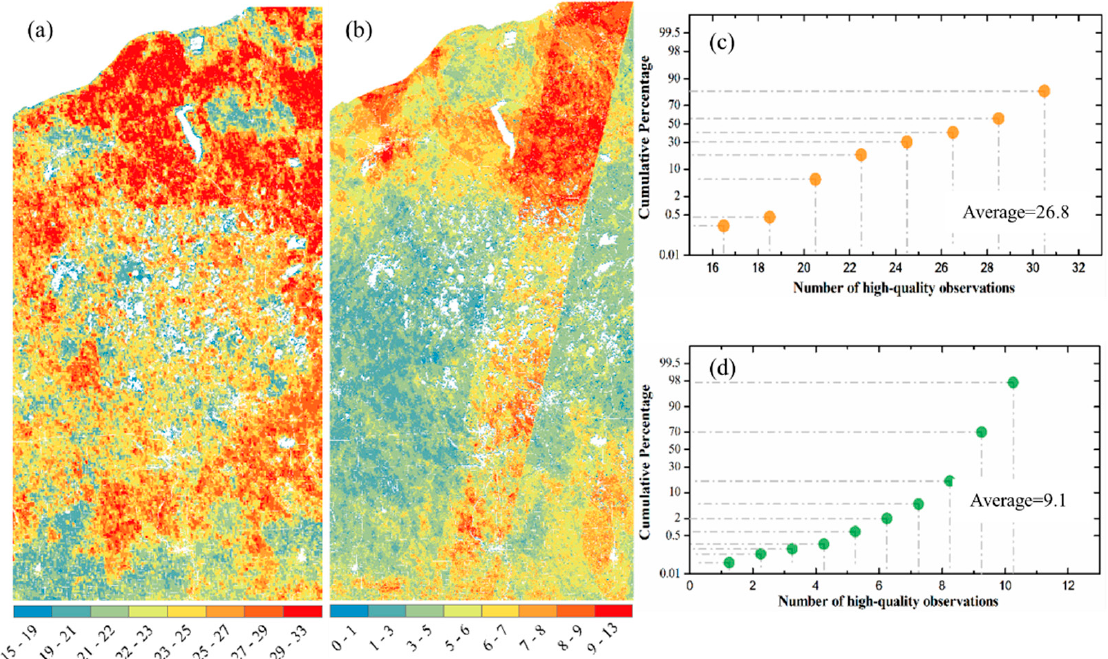
Figure 2. Number of high-quality 3-day observations by ( a ) ABI and ( b ) HLS data in study area around the greenup onset (astronomical spring from 20th March to 20th June) in 2018. ( c , d ) show the cumulative areal (or pixel) percentages with ABI and HLS high-quality observation numbers, respectively, calculated from ( a , b ).